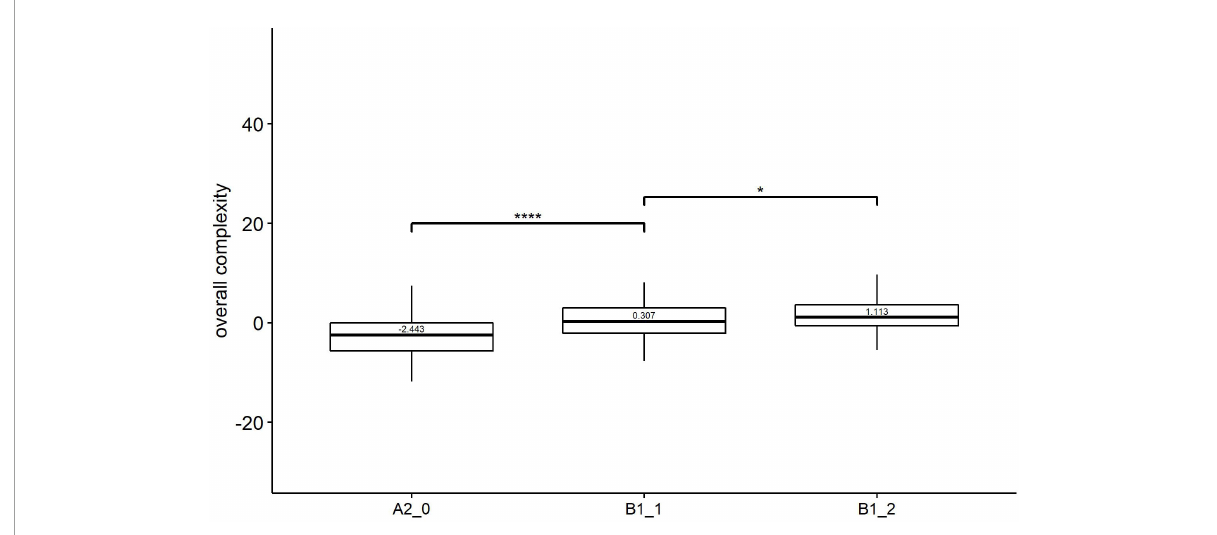
FIGURE1 Paired comparisons across learner proficiency levels on Kolmogorov overall complexity. * p < 0.01; **** p <